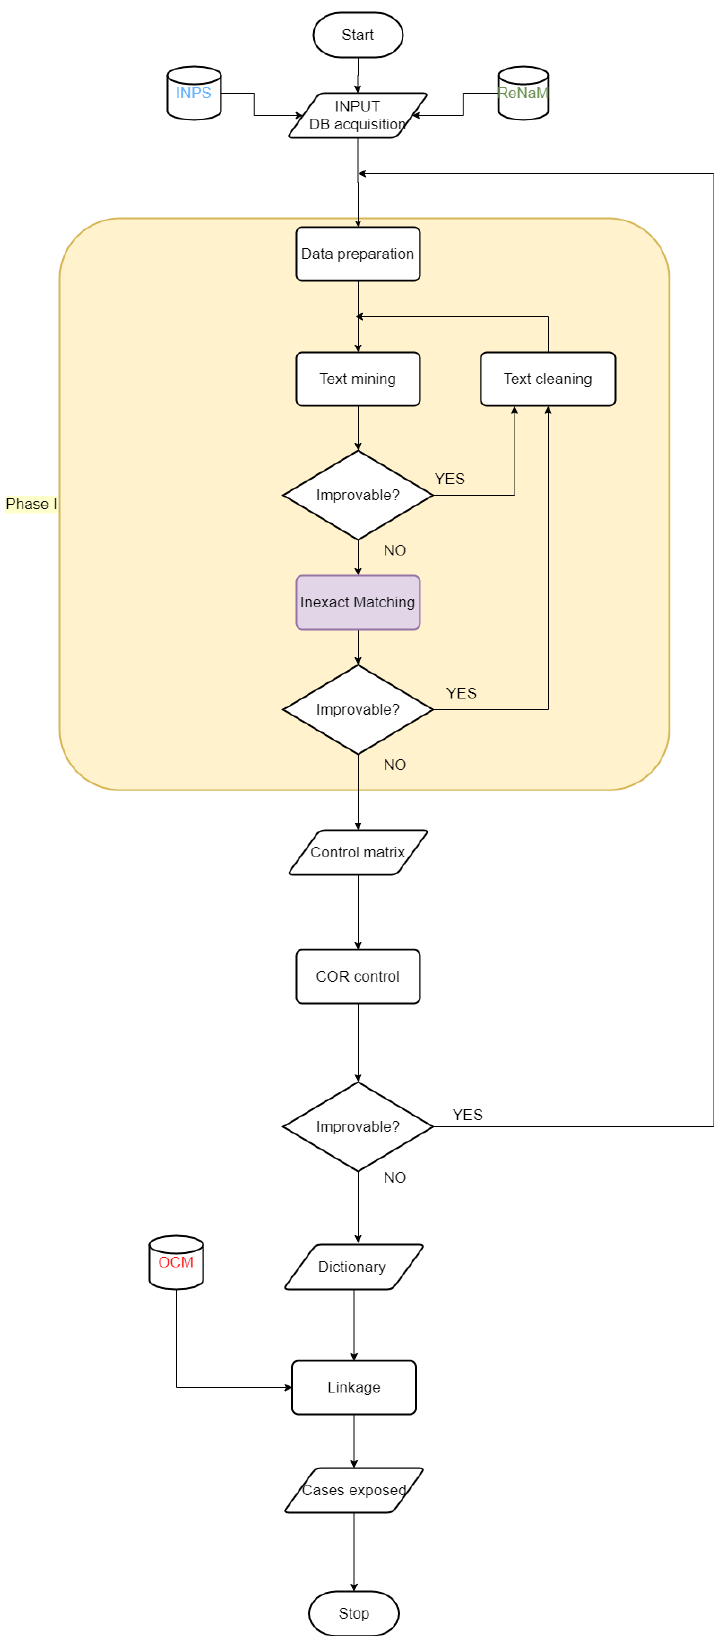
Figure 2. Flowchart of the record linkage process.